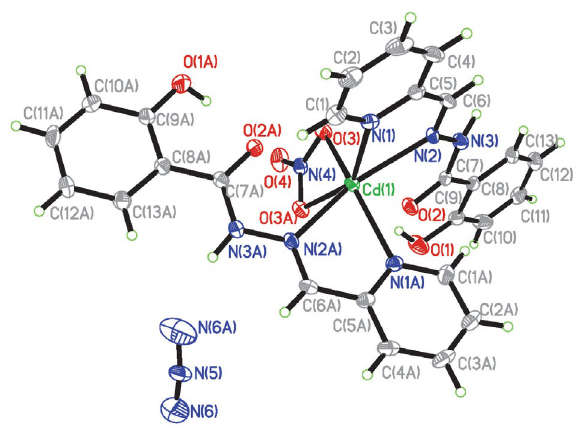
Figure 1. A perspective view of complex 1 with the atom labeling scheme. Thermal ellipsoids are drawn at the 30% probability